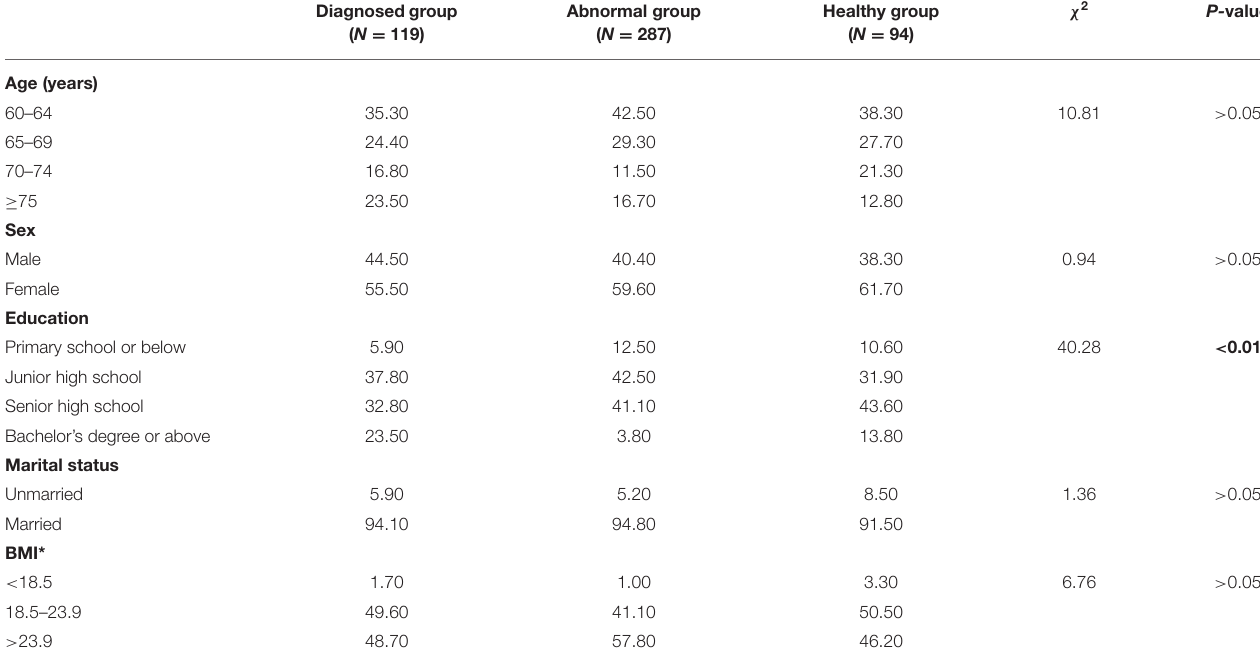
TABLE 1 | Descriptive statistics of all included participants ( N = 500,